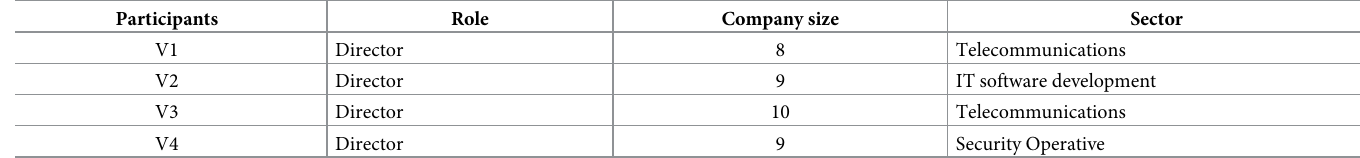
Table 1. Preliminary study participants and the company